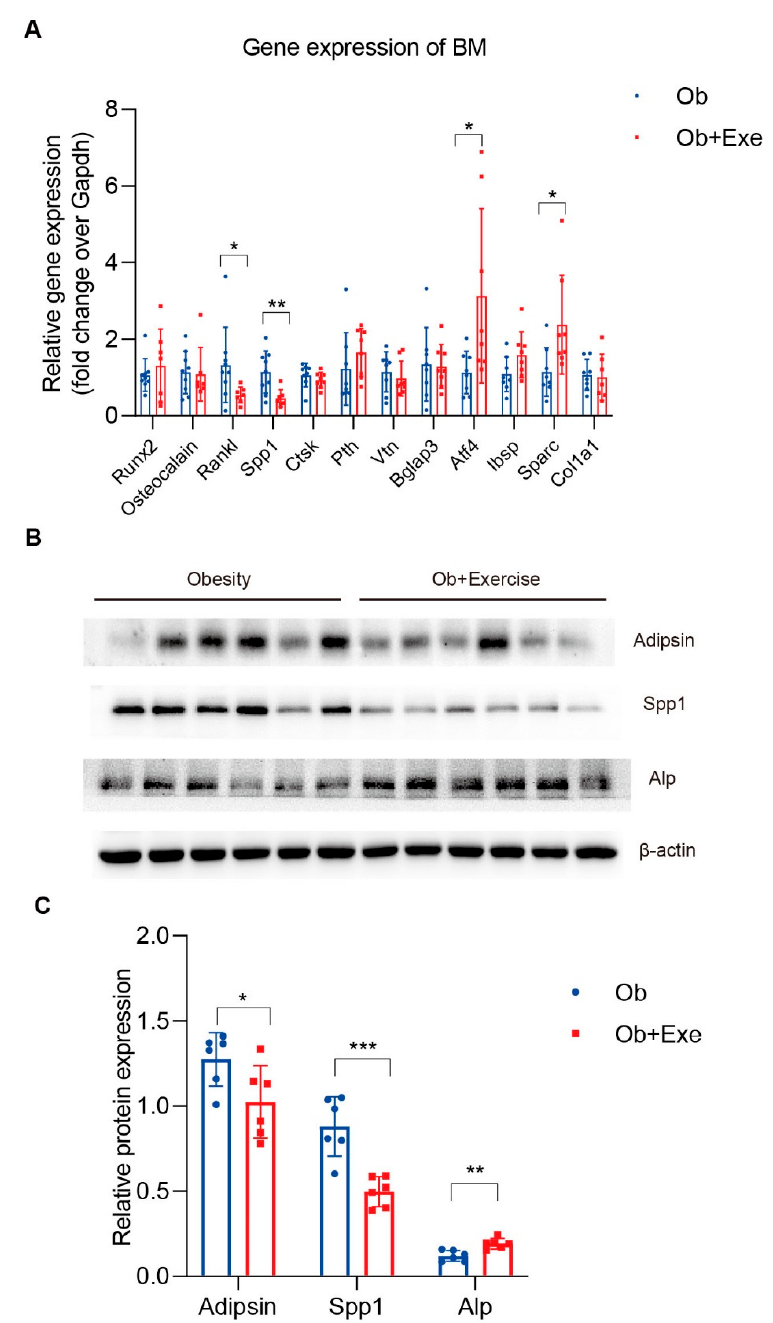
Figure 3. Exercise inhibited bone resorption and protected bone by reducing adipsin and Spp1. Quantitative real-time PCR analyses and protein expression level of tibia BM. ( A ) Bone remodeling related gene expression quantitative analysis of bone marrow. The bone marrow was isolated from the male C57/B6 mice ( N = 9) that were induced for 6 weeks of high-fat diet and intervened in twelve weeks of exercise. * p < 0.05, ** p < 0.01, *** p < 0.001 for obesity group ( N = 9) vs exercise group ( N = 7). ( B , C ) Western blotting and quantification ( N = 6) in tibia bone marrow from obesity group and exercise group. * p < 0.05, for obesity group ( N = 6) vs exercise group ( N = 6). * p < 0.05, ** p < 0.01 2- sided Student t tests were used for statistical analyses. Data are presented as mean ± SD. BMAT, bone marrow adipose tissue; PCR, polymerase chain reaction.